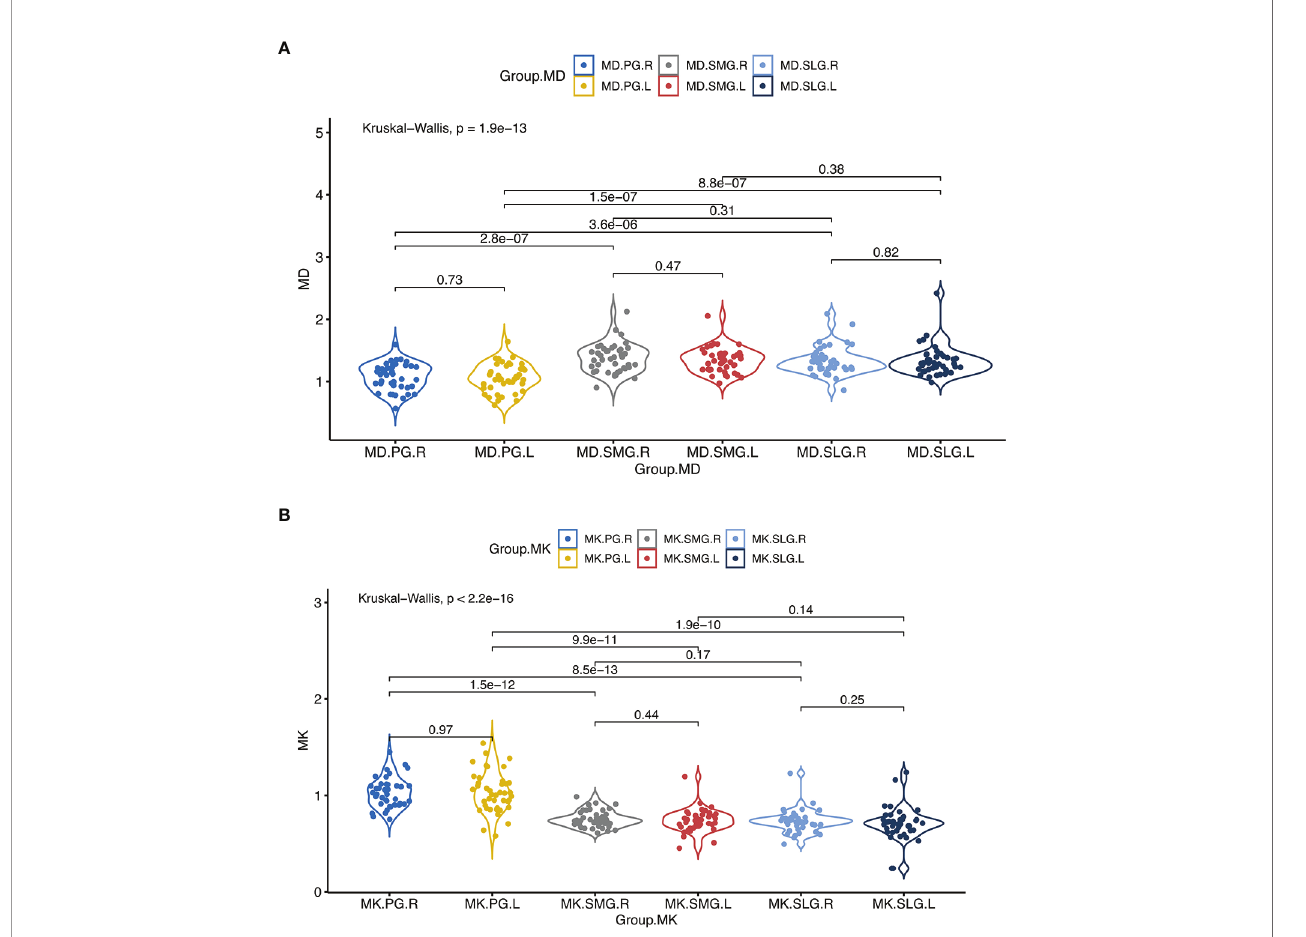
FIGURE 2 | (A) denotes comparisons of MD between the left and the right side of the major salivary glands, and between ipsilateral PG, SMG, and SLG; (B) denotes comparisons of MK between the left and the right side of the major salivary glands, and between ipsilateral PG, SMG, and SLG. Abbreviations are referred to in Table 2